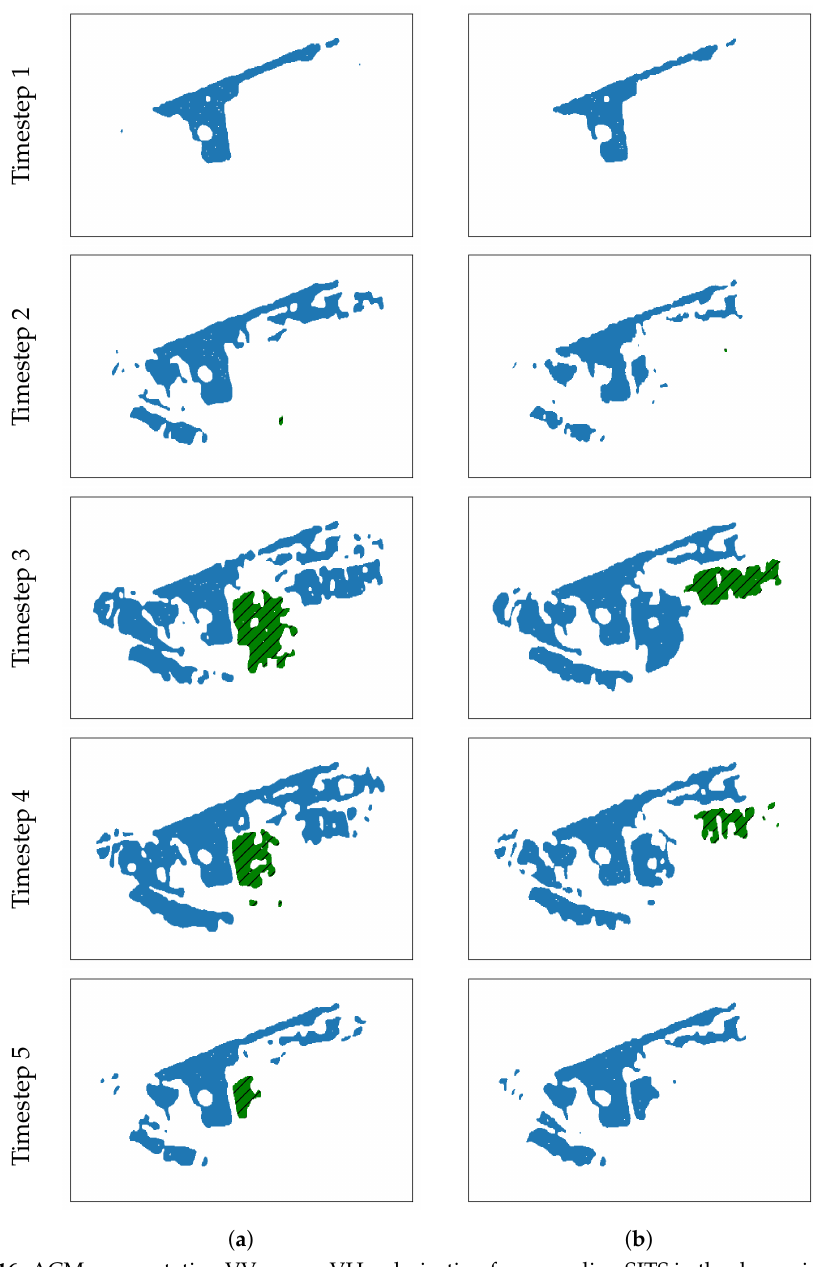
Figure 16. ACM segmentation VV versus VH polarisation for ascending SITS in the dynamic zone. Blue polygons represent permanent entities, and green polygons represent temporary entities. ( a ) Ascending VV. ( b ) Ascending